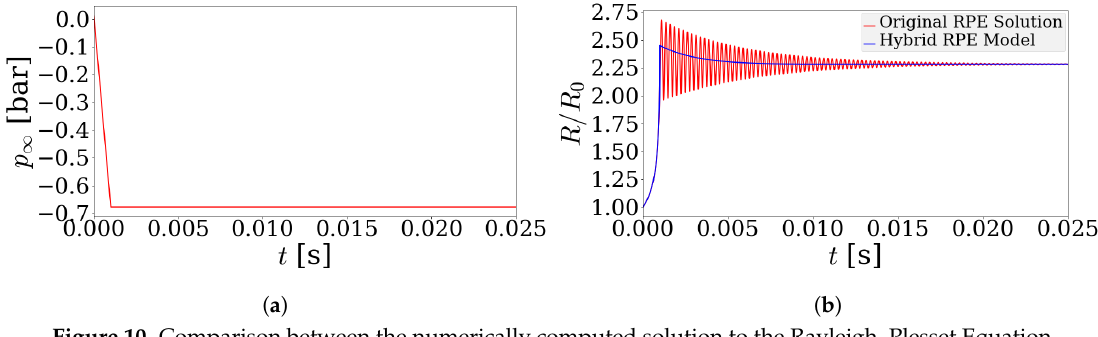
Figure 10. Comparison between the numerically computed solution to the Rayleigh–Plesset Equation and solution obtained using the proposed model with instantaneous non-dimensionalization parameters in ( b ), based on a forced linear pressure variation at a distance from the bubble interface shown in ( a ).